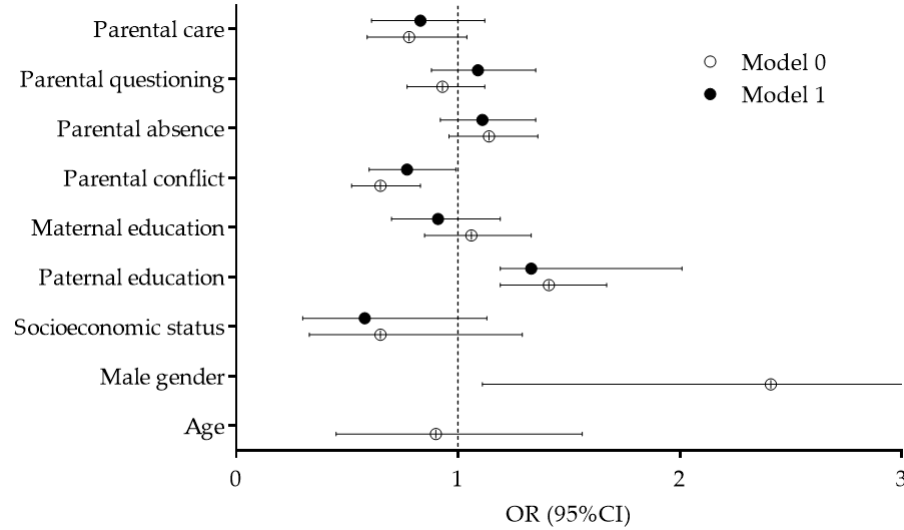
Figure 4. Correlates of sufficient physical activity levels during COVID-19 pandemic (Model 0 — crude logistic regression model non-controlled for covariates, Model 1 — logistic regression controlled for gender and age).